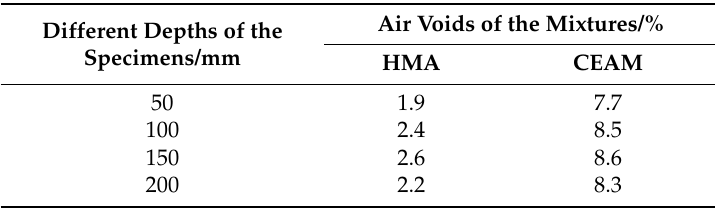
Table 10. Air voids of the mixtures at different